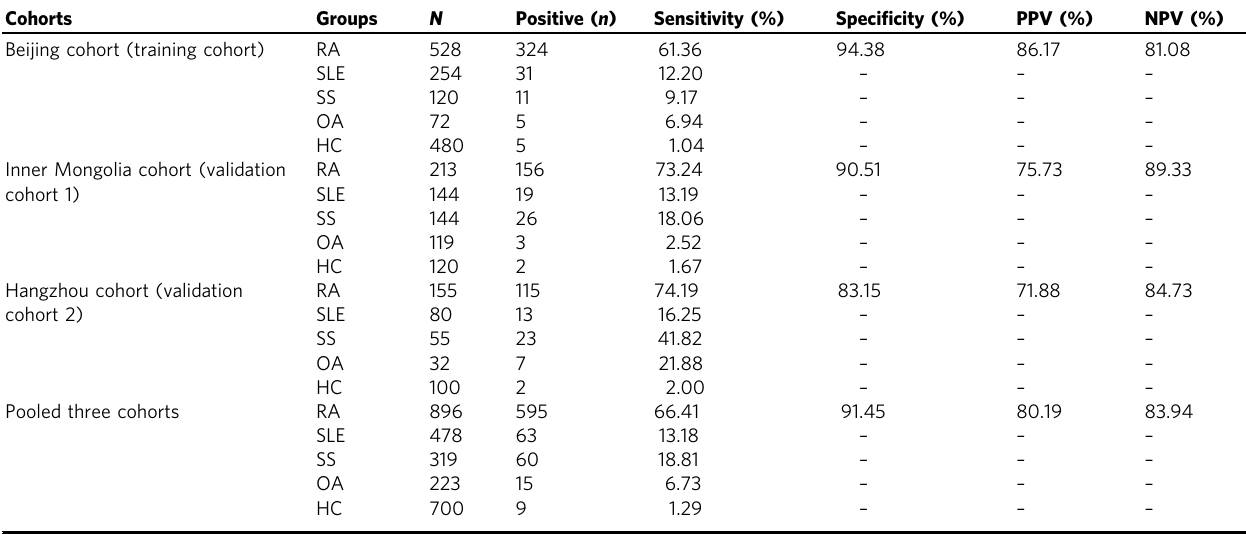
Table 1 Sensitivity and speci fi city of sSR-A in RA diagnosis.